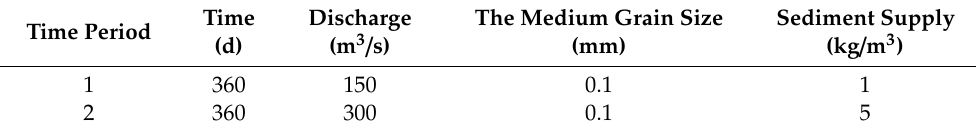
Table 4. The experimental conditions.